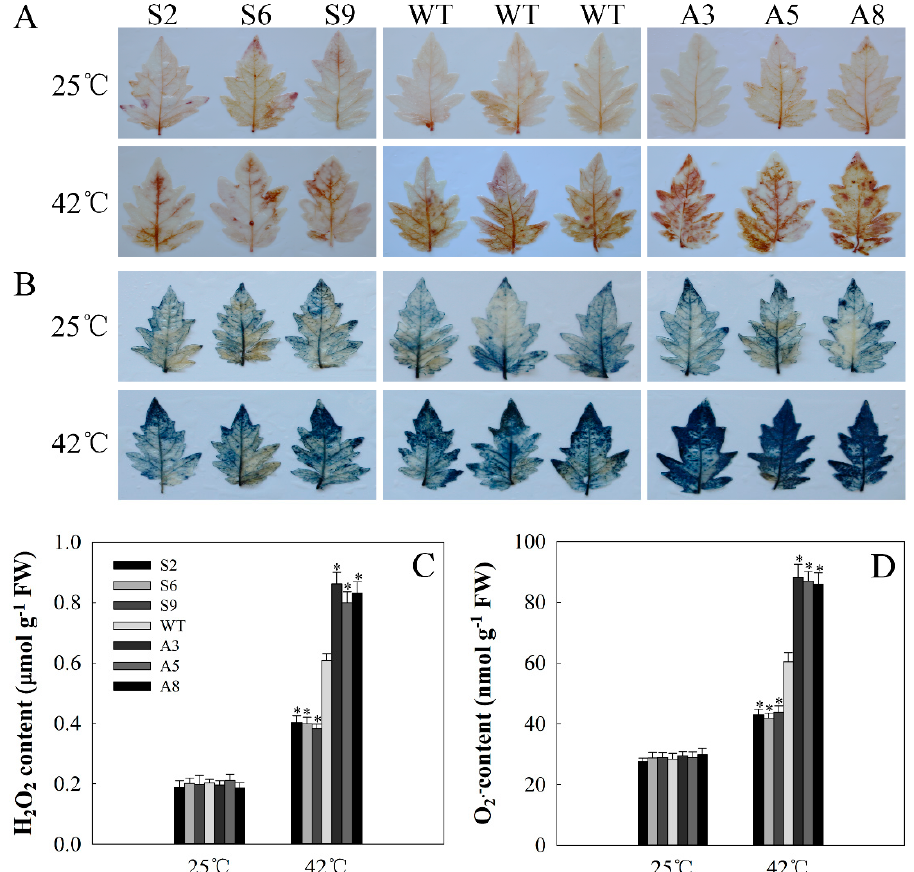
Figure 7. Reactive oxygen species (ROS) analysis in WT and transgenic lines: ( A ) 3 ′ ,3-diaminobenzidine (DAB) staining for H 2 O 2 ; ( B ) nitroblue tetrazolium (NBT) staining for O 2 • − . The upper layer represents plants grown at 25 °C and the lower layer represents plants subjected to 42 °C for 12 h. ( C ) H 2 O 2 content; ( D ) O 2 • − content. The mean values ± SD of at least three replicates are presented, and * p < 0.05 indicate significant differences compared with the control.